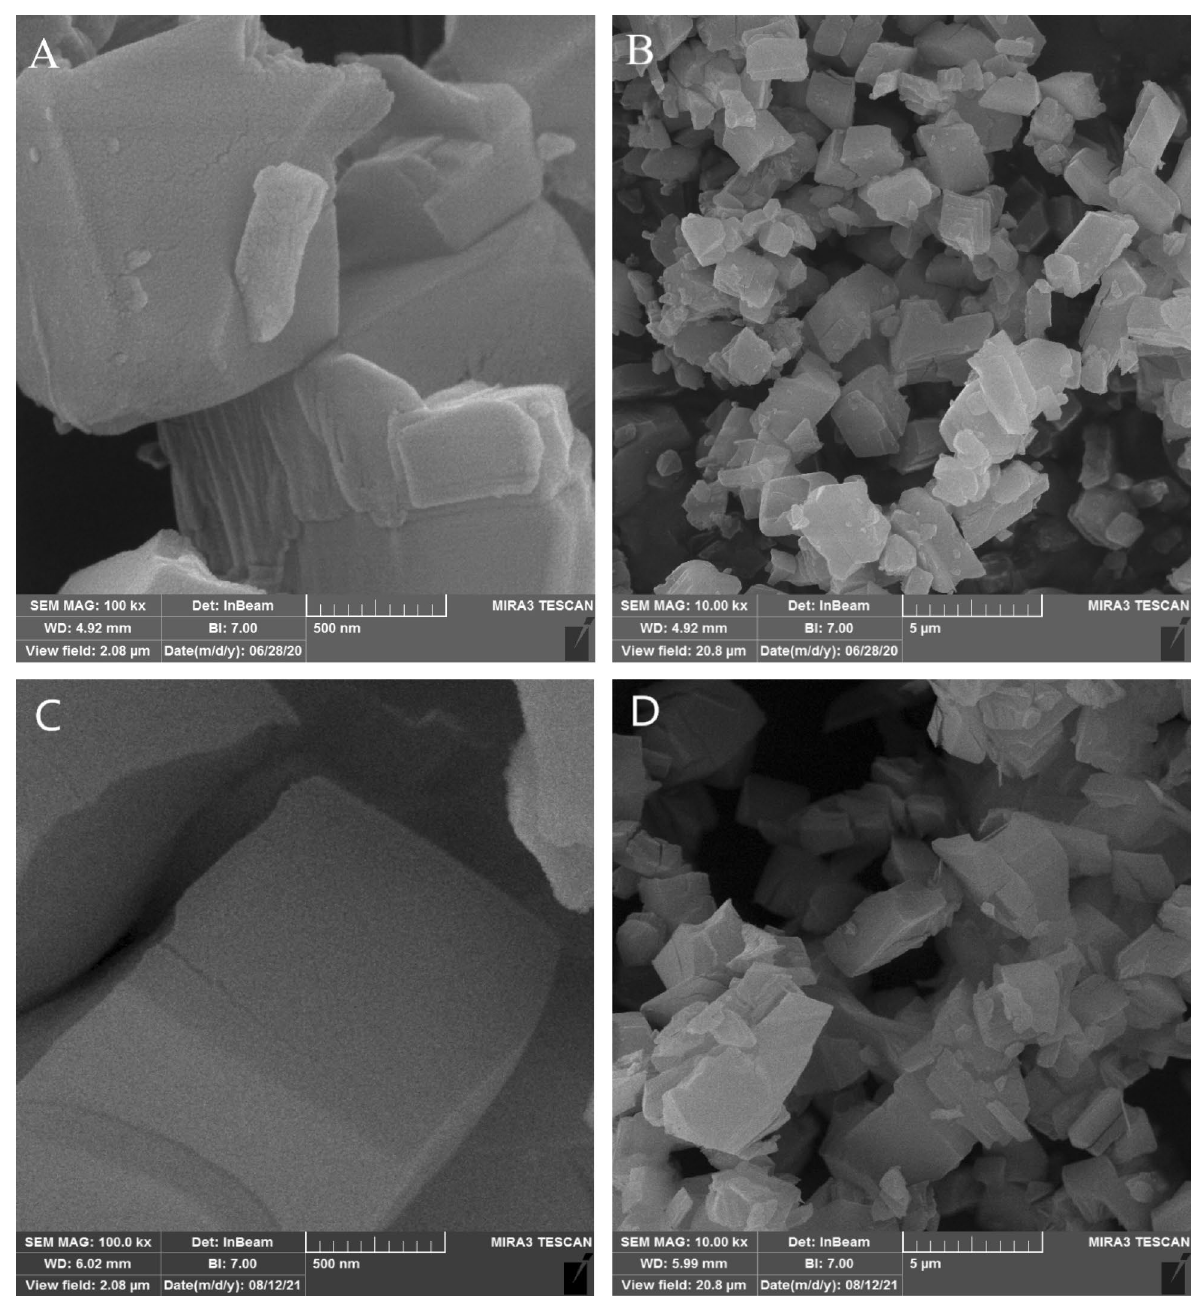
Figure 2. FESEM images of ( A , B ) UAS MIL-53(Al); ( C , D ) CS MIL-53(Al) at different